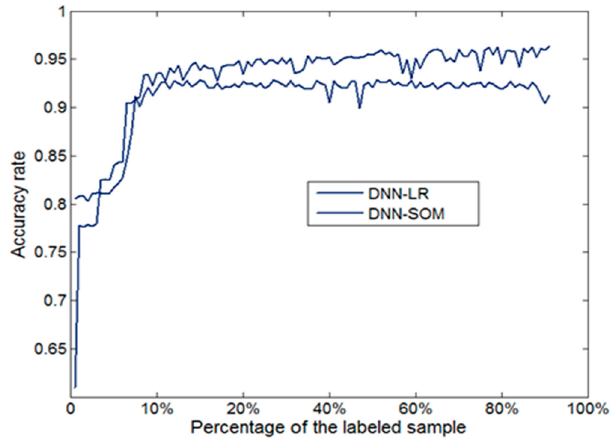
Figure 7. Classification accuracy varying with the labeled sample.